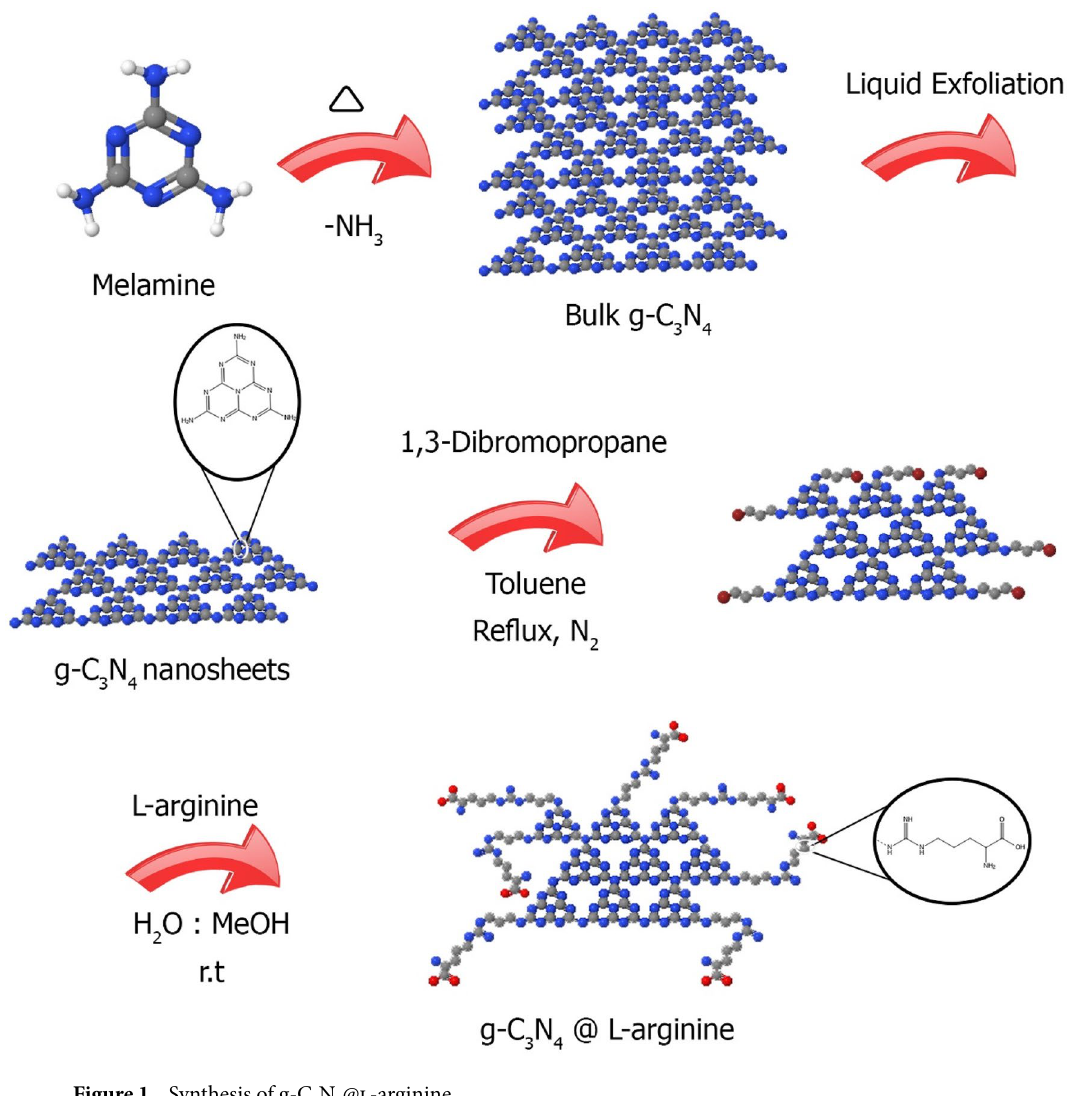
Figure 1. Synthesis of g-C 3 N 4